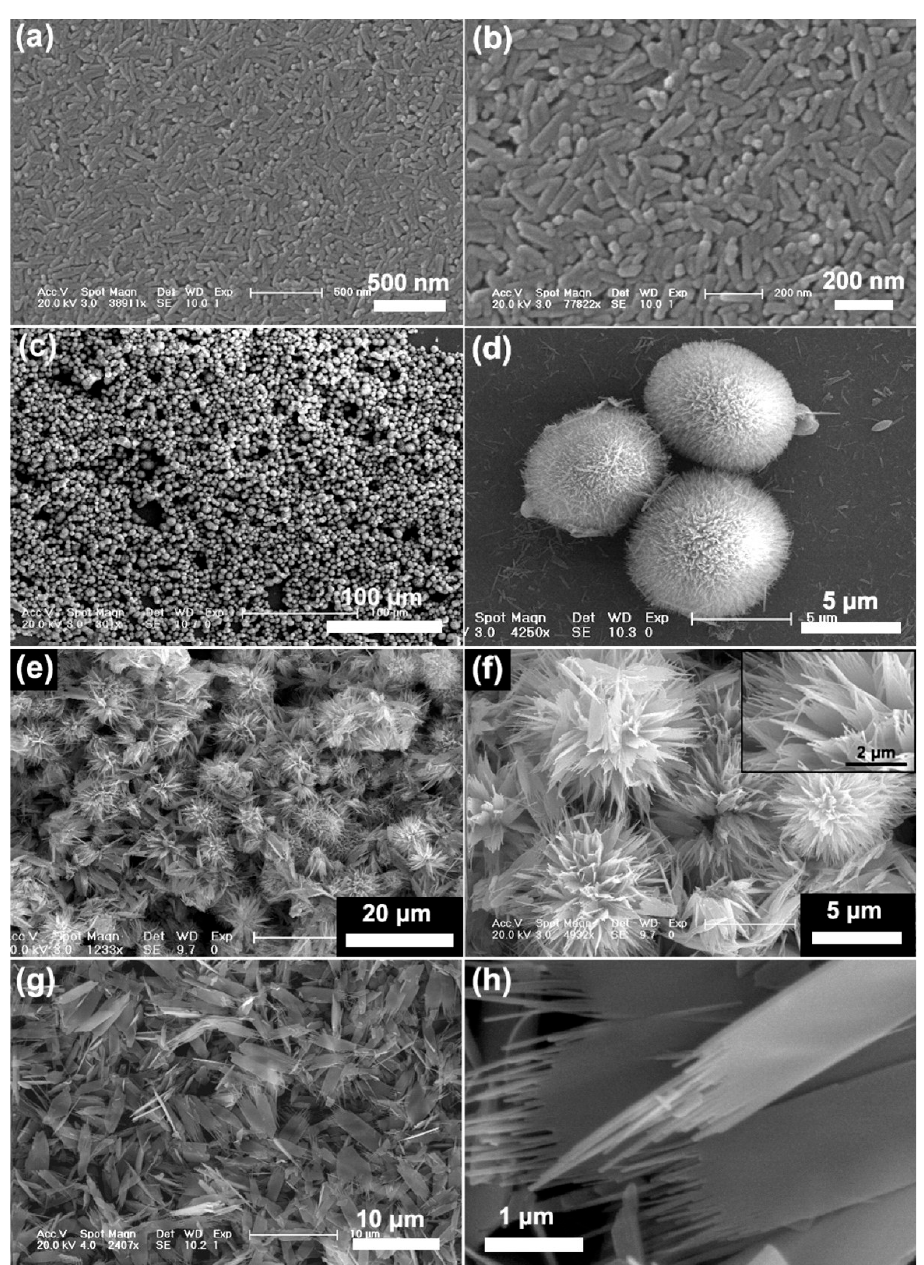
Figure 5. Nanorod ( a , b ), bur-like microsphere ( c , d ), microflower ( e , f ), and microsheet ( g , h ) morphologies that can be obtained from precipitation media having pH values of 7.0, 5.0. 4.5, and 4.0, respectively. Reprinted with permission from [19]. Copyright 2009 American Chemical Society.